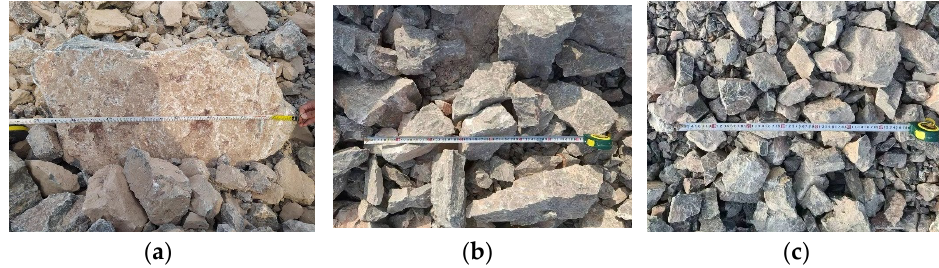
Figure 11. Typical rock fragmentations. ( a ) Working condition 1. ( b ) Wording condition 2. ( c ) Work- ing condition 3. ( c ) Working condition